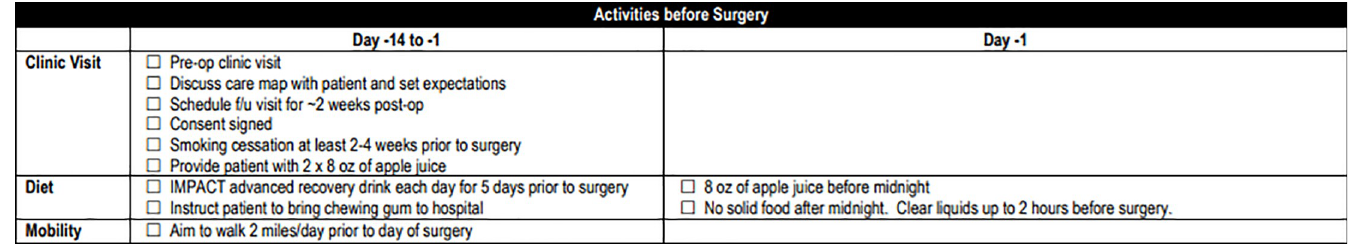
Fig 1. Whipple Pre-operative Pathway.